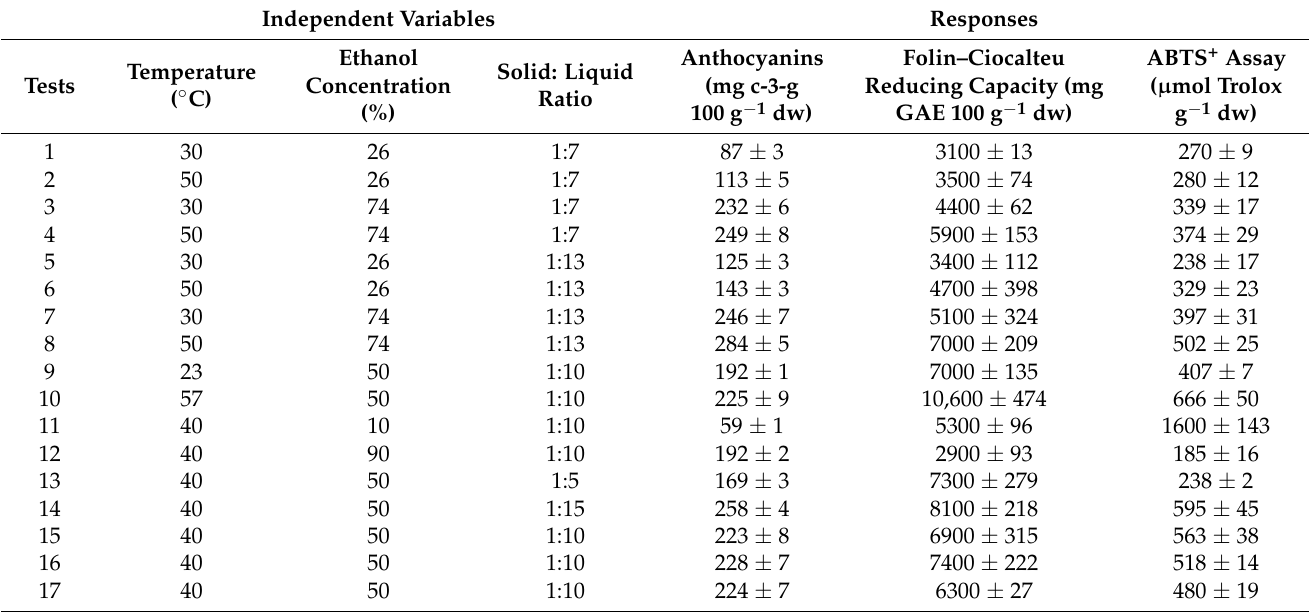
Table 1. Results found from 17 tests using agitated bed